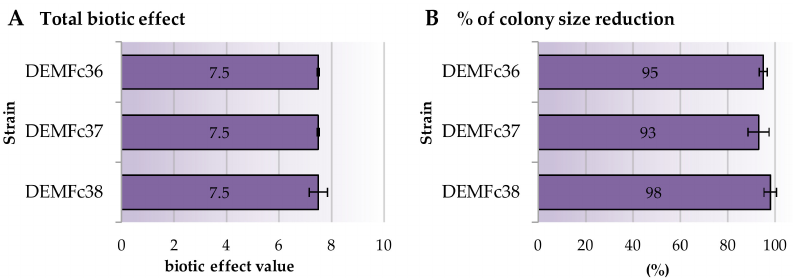
Figure 4. The values of total biotic e ff ect ( A ) of the Trichoderma DEMTkZ3A0 strain and ( B ) reduction of colony size (%) of pathogenic Fusarium spp. strains ( F. graminearum DEMFc36, F. culmorum DEMFc37, and F. oxysporum DEMFc38) by the DEMTkZ3A0 strain on potato dextrose agar (PDA) medium, after 14 days of incubation at 20 ◦ C.